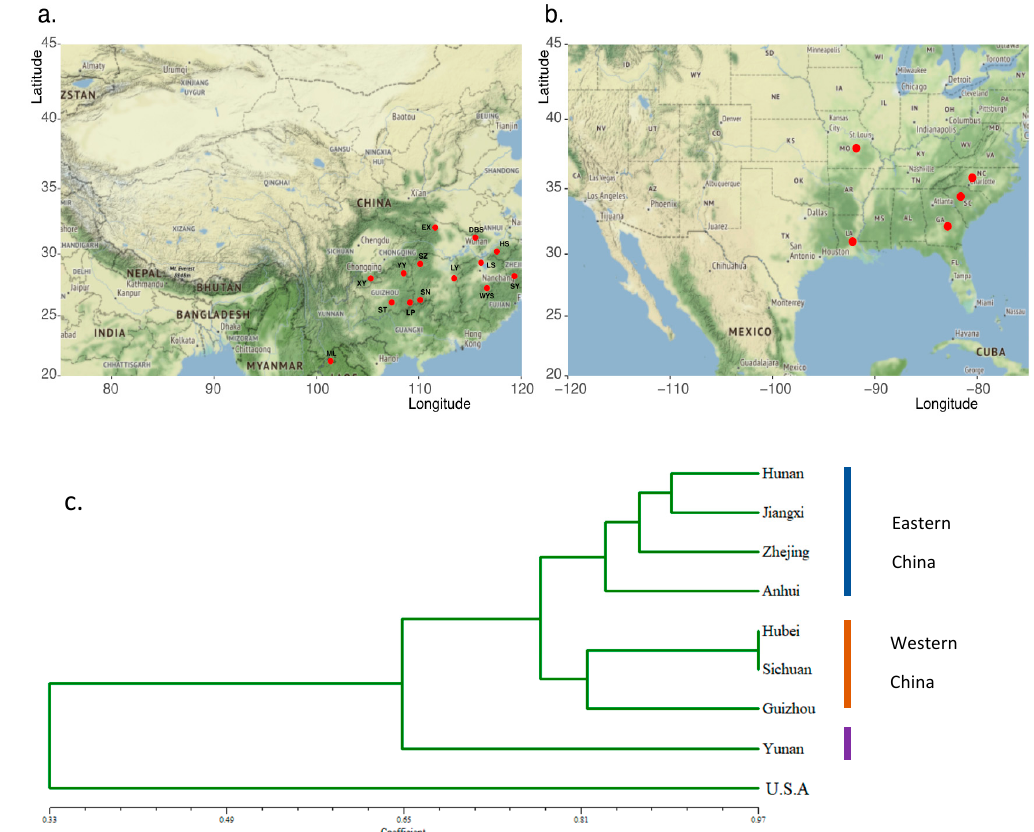
Figure 1. ( a ) Geographic distribution of the origin of 14 Liriodendron chinense (Hemsl.) Sarg. ( L. chinense ) populations sampled in this study; ( b ) Geographic distribution of the origin of five Liriodendron tulipifera L. ( L. tulipifera ) populations sampled in this study; ( c ) The UPGMA (unweight pair-group method with arithmetic means) dendrogram generated cluster analysis based on the genetic diversity of eight di ff erent provinces L. chinense samples. The L. tuilipifera plants were taken as a whole part. The L. chinense plants in this study were grouped into three clusters (blue, Eastern China; Orange,